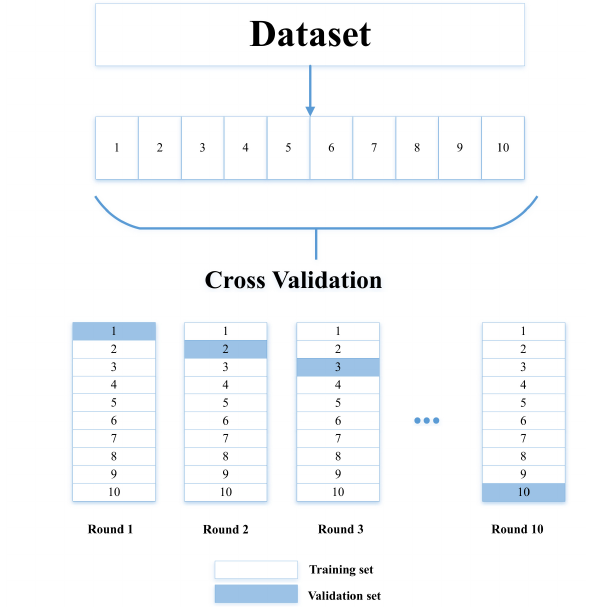
Figure 8. Cross-Validation, the 10 subsets are randomly selected.